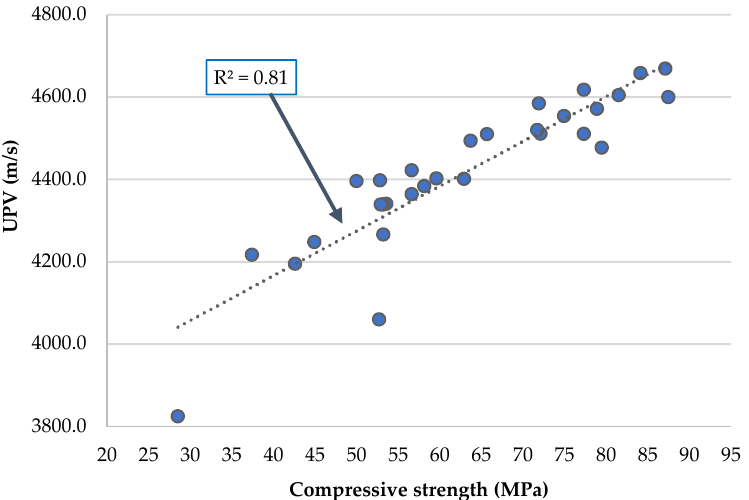
Figure 8. Ultrasonic pulse velocity at 91 and 365 days of curing as a function of the compressive strength, f cm , at the same age.